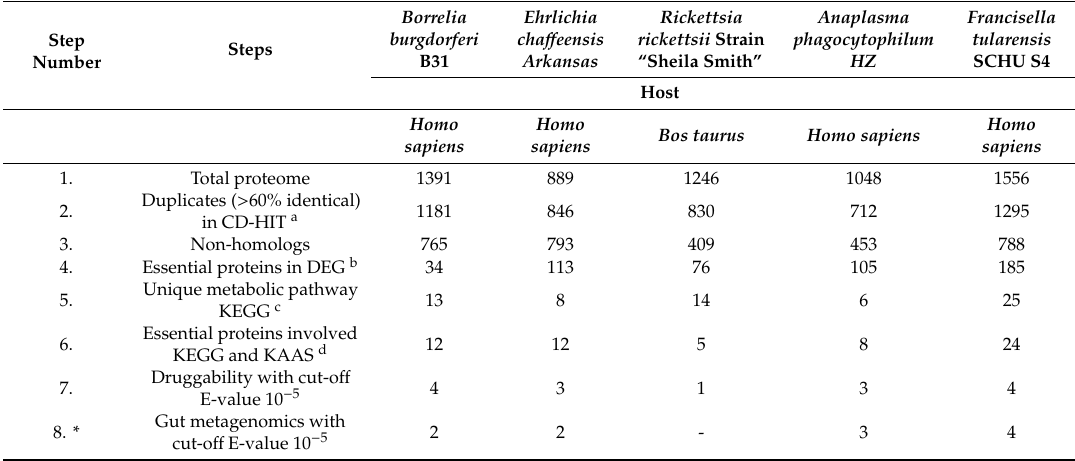
Table 1. Subtractive proteome analysis and proteins involved in metabolic pathways of selected tick-borne